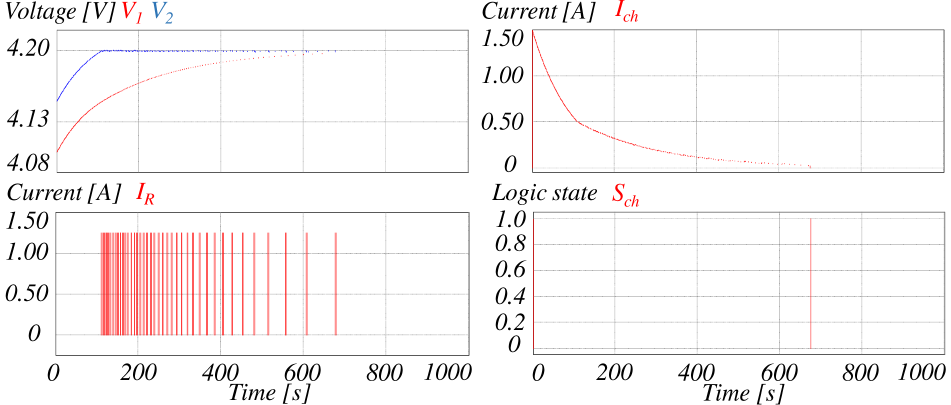
Figure 14. Resistor-based mode of operation with constant-voltage charge method ( V ch = 8.4